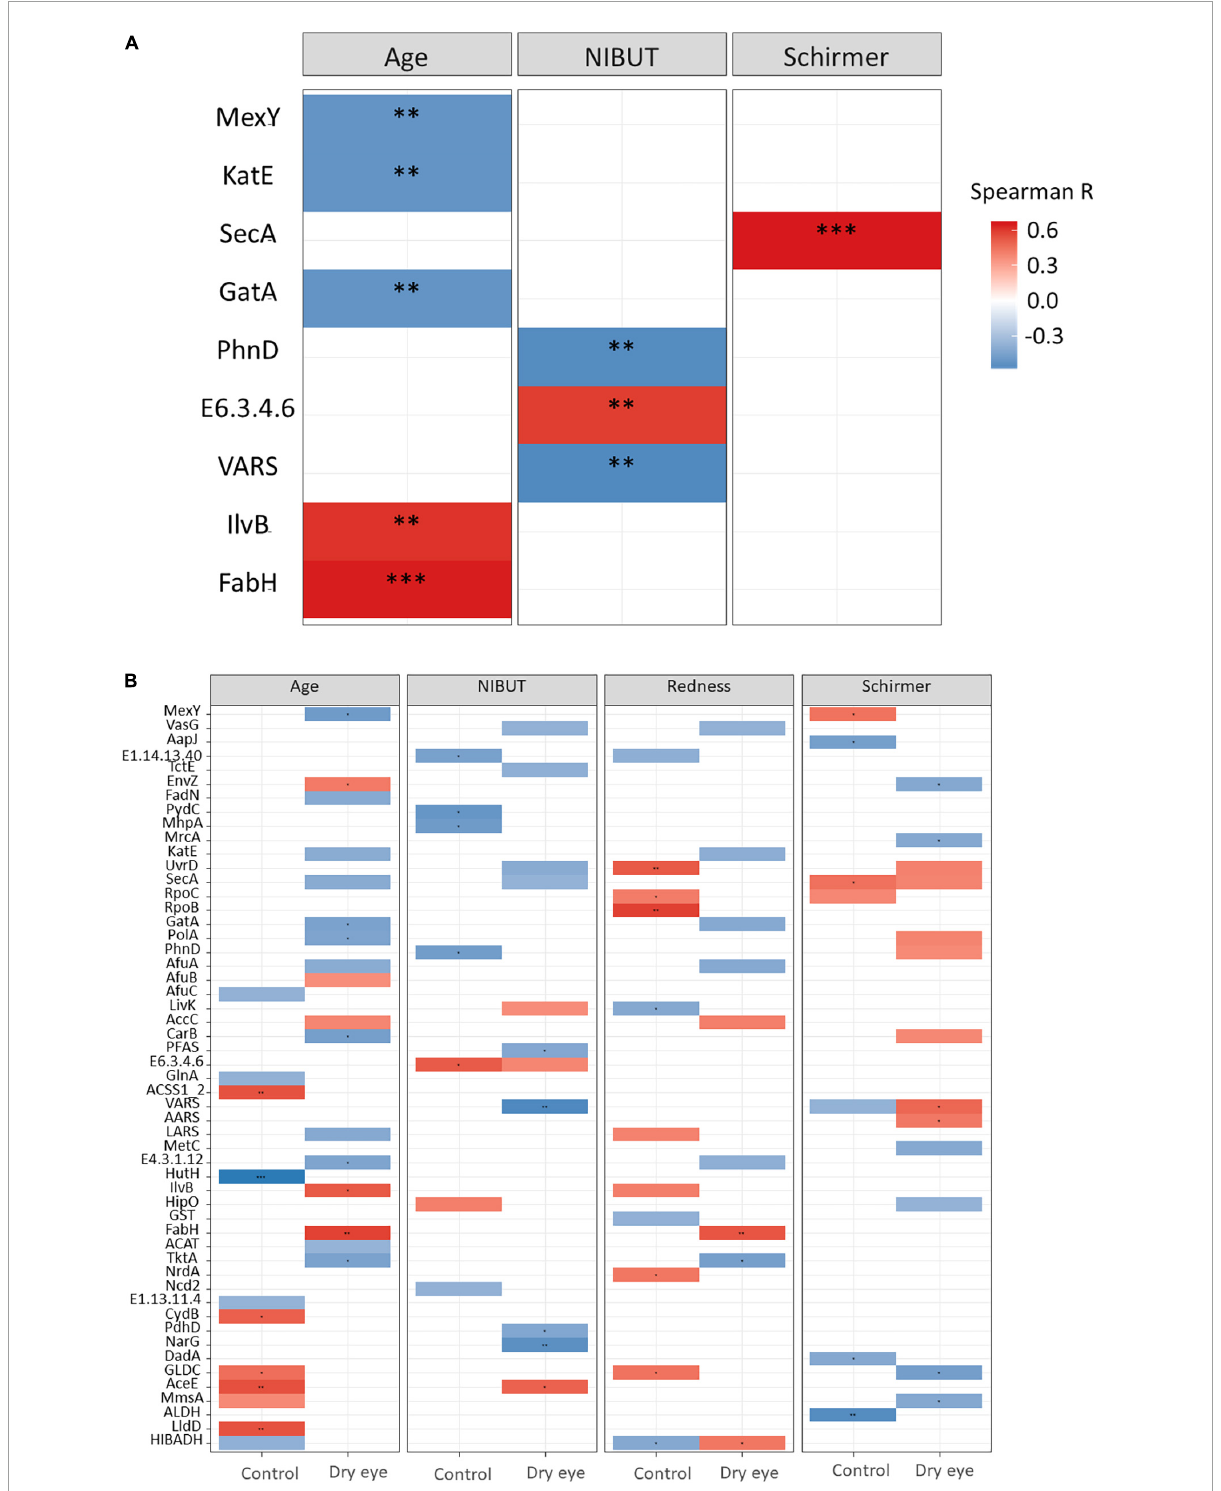
FIGURE5 Results of functional gene analysis. (A) Correlation between KEGG functional classes and age, non-invasive tear break-up times (NIBUT) and Schirmer test for all participants. (B) Relationship between functional genes and age, NIBUT, conjunctival redness and Schirmer test, stratified by dry eye and control participants. The value of the Spearman correlation coefficient, which measures the strength and direction of association between two ranked variables, is color-coded. Red indicates positive correlation and blue indicates negative or inverse correlation. ∗ p < 0.05; ∗∗ p < 0.01; ∗∗∗ p < 0.001. Supplementary Tables 4, 5 listed the full names of KEGG functional